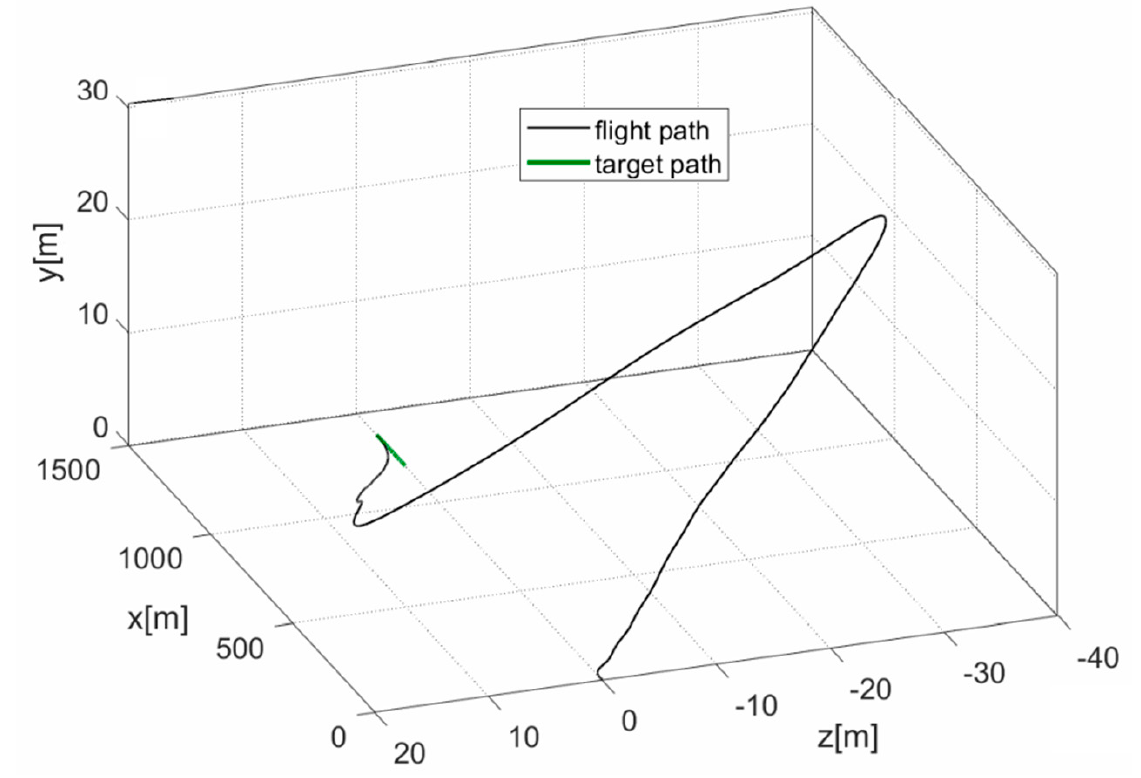
Figure 5. The performed trajectory in the 3D space.